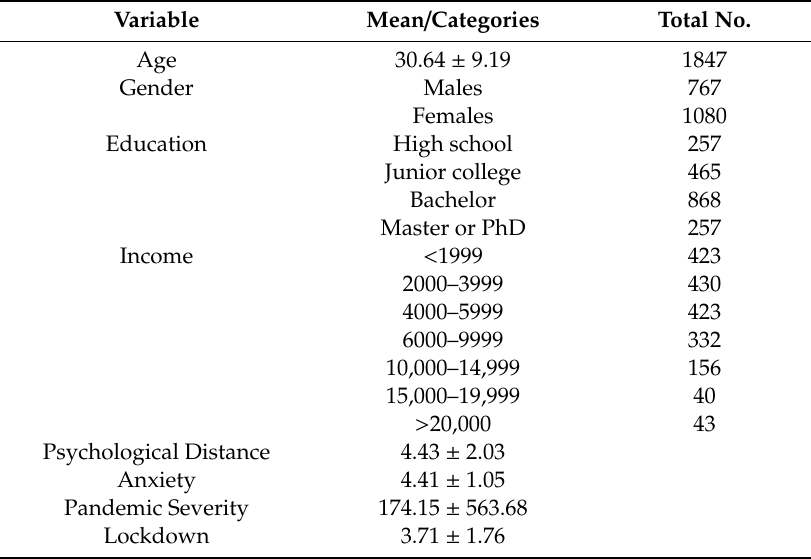
Table 1. Demographic and variables